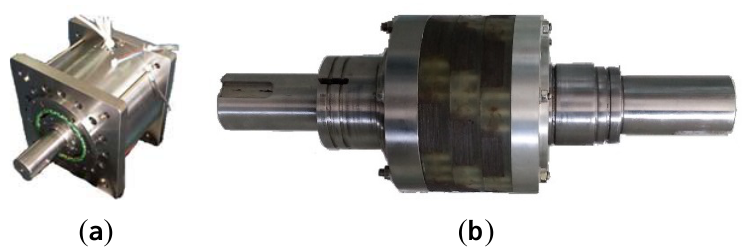
Figure 25. A prototype of the MGDRM: ( a ) Prototype; ( b ) Assembly of the inner and outer